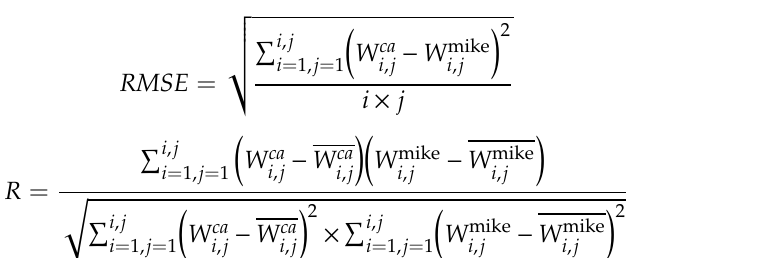
( a ) ( b ) ( c ) Figure 8. Inundation estimated by ( a ) MIKE 21 and ( b ) the CA simulated inundation, and ( c ) their difference (MIKE 21-CA) at 240 min. ( a ) ( b ) ( c ) Figure 9. Inundation estimated by ( a ) MIKE 21 and ( b ) the CA simulated inundation, and ( c ) their difference (MIKE 21-CA) at 480 min.